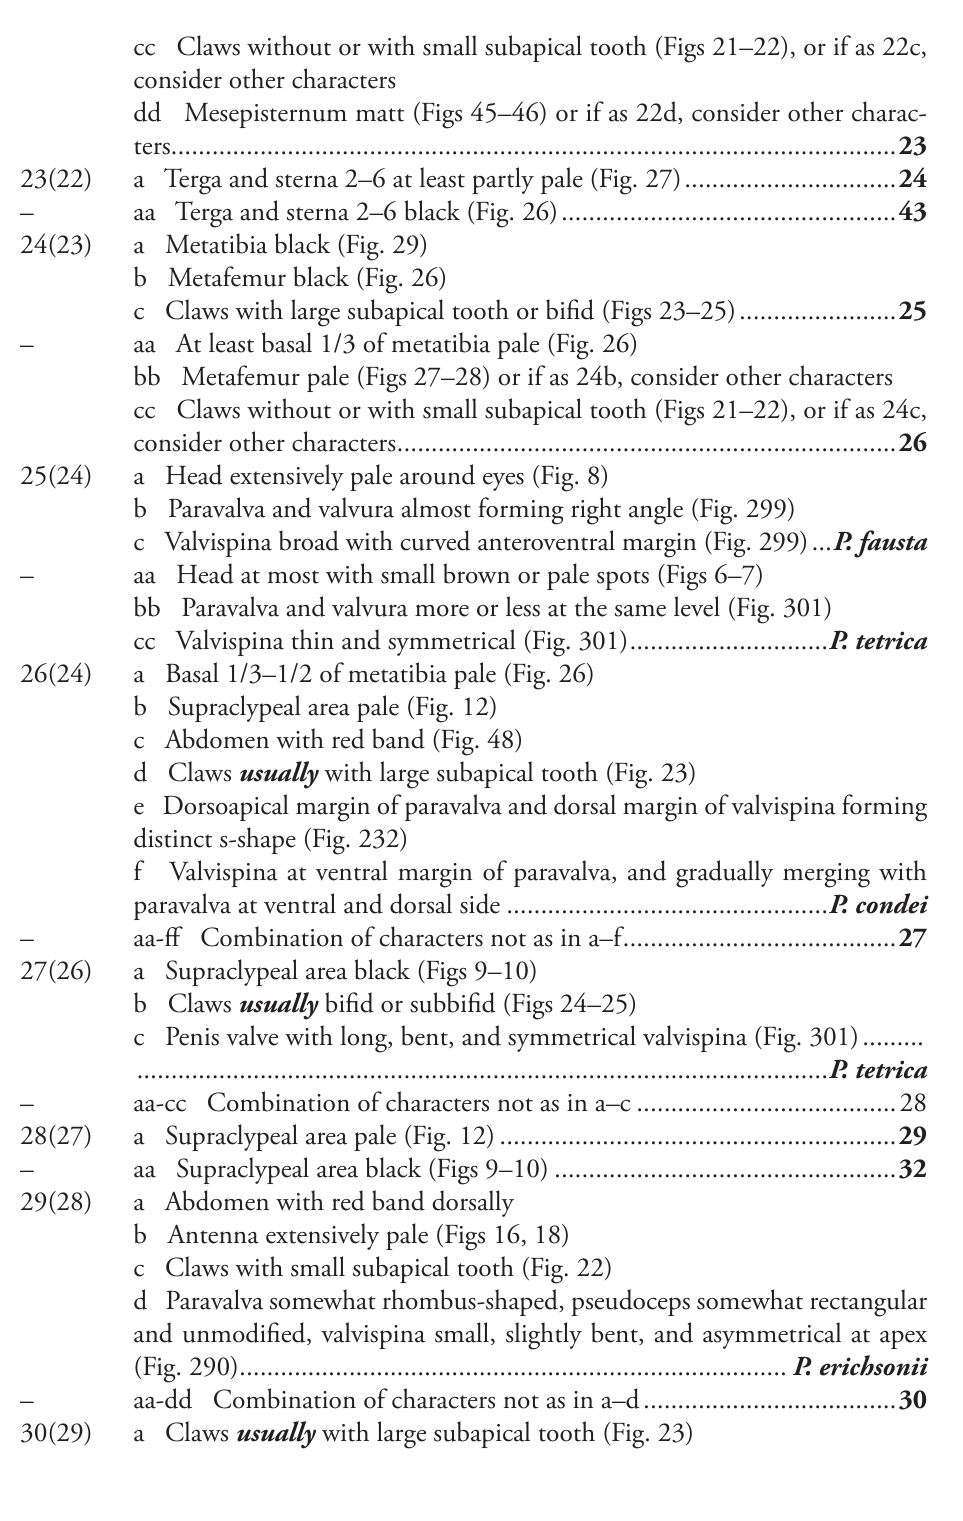
c Abdomen with red band (Fig. 48) d Claws usually with large subapical tooth (Fig.